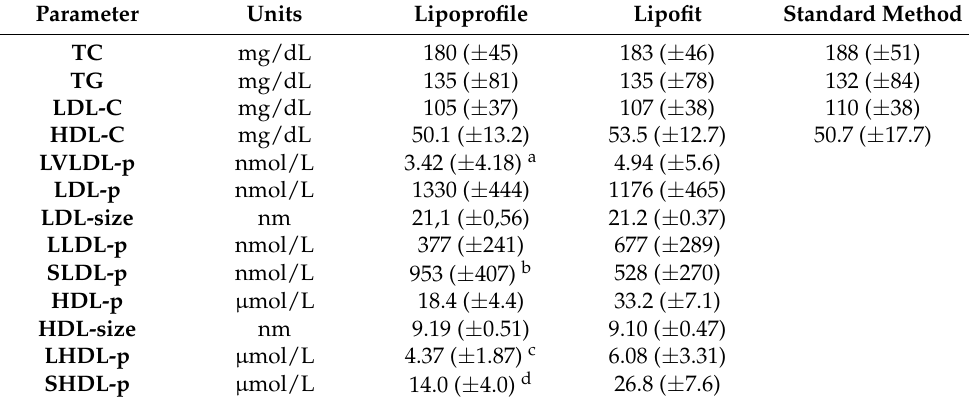
Table 1. Mean concentrations of standard lipids and lipoprotein (sub)classes.